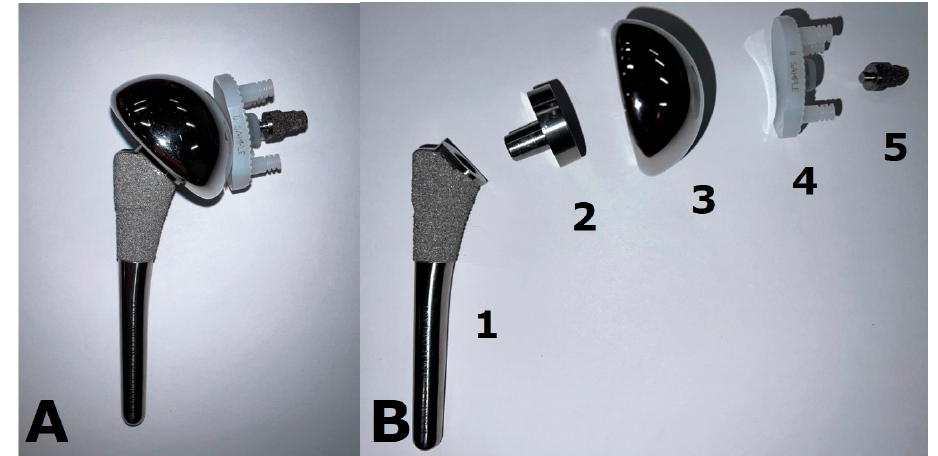
Figure 2. Example of an anatomic total shoulder arthroplasty (ATSA) implant. This prosthesis is shown ( A ) assembled and ( B ) deconstructed. The stem (1) is porous-coated proximally to allow for biologic osseous integration. The humeral head (3) is fixed to the stem via a Morse-tapered trunnion (2). Note the asymmetry of the trunnion, which allows for matching of the eccentricity of the native humeral head. The glenoid component (4) is composed of polyethylene plastic. The top and bottom pegs are cemented in place, while the metal post (5) is press-fit and allows for biologic osseous in- tegration.